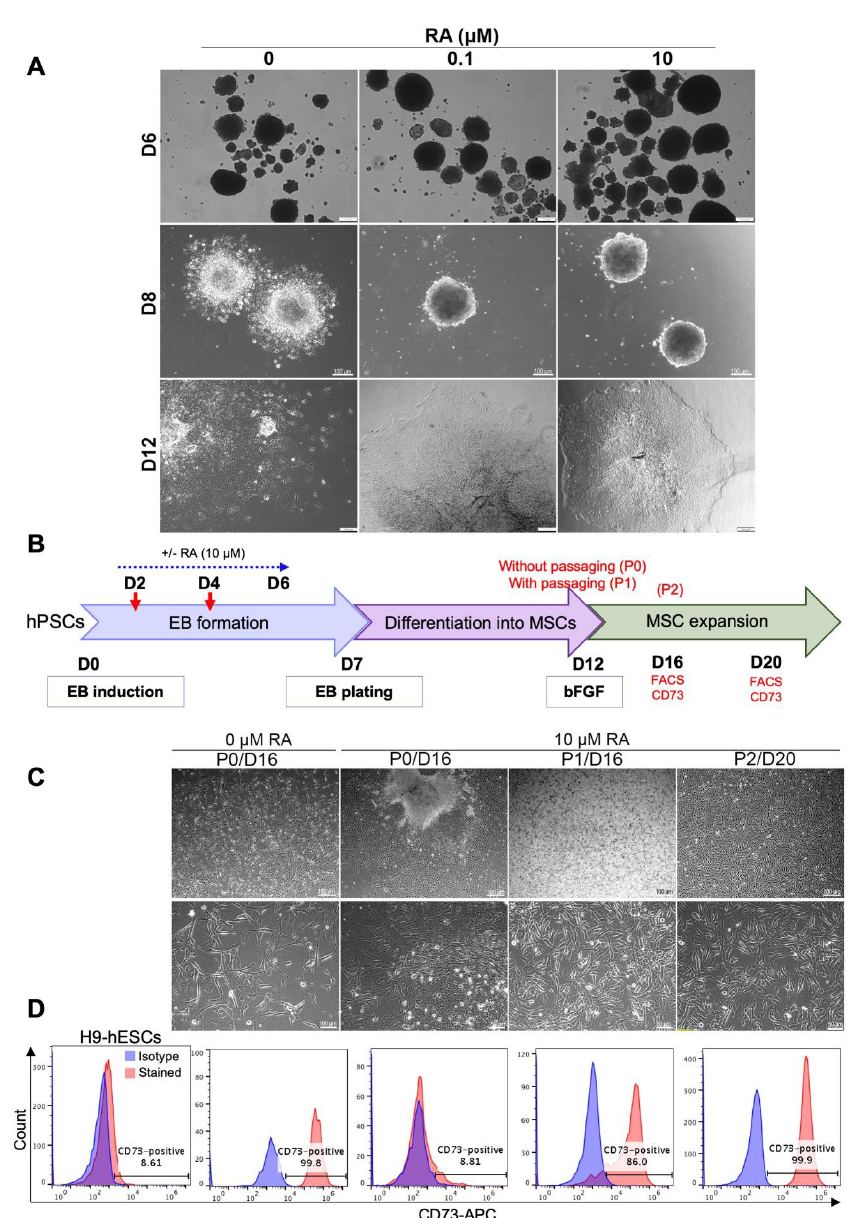
Figure 2. RA-mediated delay in EB di ff erentiation can be reversed by cell dissociation. ( A ) E ff ect of RA treatment on EB morphology after plating on matrigel-coated dishes. H9 ESC-derived EBs treated or not with RA were plated on matrigel-coated dishes on day 7 of di ff erentiation. Representative images were taken on days 6, 8 and 12 of di ff erentiation. ( B ) E ff ect of dissociation and replating on the di ff erentiation of RA-treated EBs into MSC-like cells. As indicated in the experimental scheme, H9 ESC-derived EBs treated or not with RA (10 µ M condition) were dissociated (P1) or not (P0) on D12 of di ff erentiation. A second dissociation was performed on D16 (P2). On D16 and D20, the cells were photographed to examine their morphology ( C ) and the expression of the MSC marker CD73 was analyzed by flow cytometry ( D ). Undi ff erentiated H9-hESCs were used as negative control. The images and histograms presented are representative from three independent